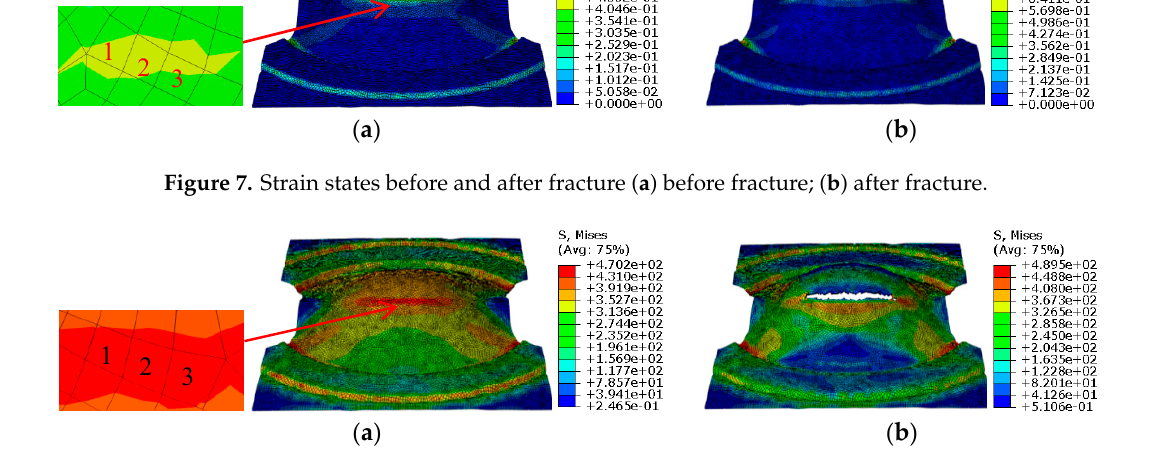
Figure 8. Stress states before and after fracture ( a ) before fracture; ( b ) after fracture.